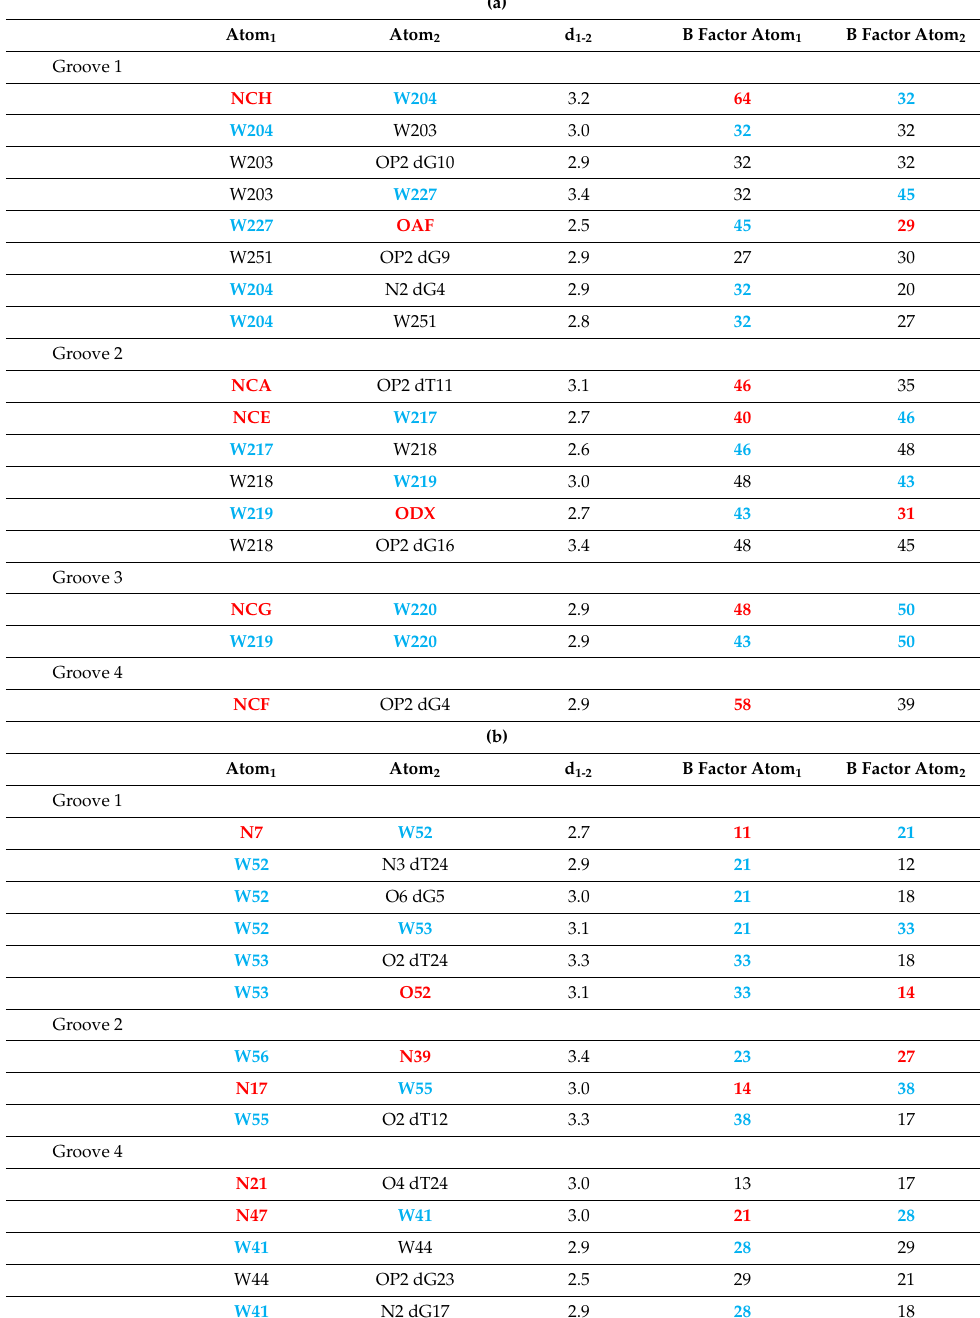
Table 2. Hydrogen bond interactions. ( a ) In structure 3UYH, involving the tetrasubstituted naph- thalene diimide MM41, a human intramolecular telomeric G-quadruplex, and water molecules. Hydrogen-bond distances are shown (d 1-2 in Å), together with the reported crystallographic B factor values (in Å 2 ) for MM41-bound waters and associated MM41 and DNA atoms. MM41 atoms are highlighted in bold red type. Waters in direct contact with MM41 atoms are highlighted in bold blue type. Numbering is as in the PDB entry. ( b ) In structure PDB id 3CE5 [74], involving the trisubstituted compound BRACO19, a human intermolecular bimolecular telomeric G-quadruplex, and water molecules. Parameter definitions and color coding are as in Table 2a. (a) Atom 1